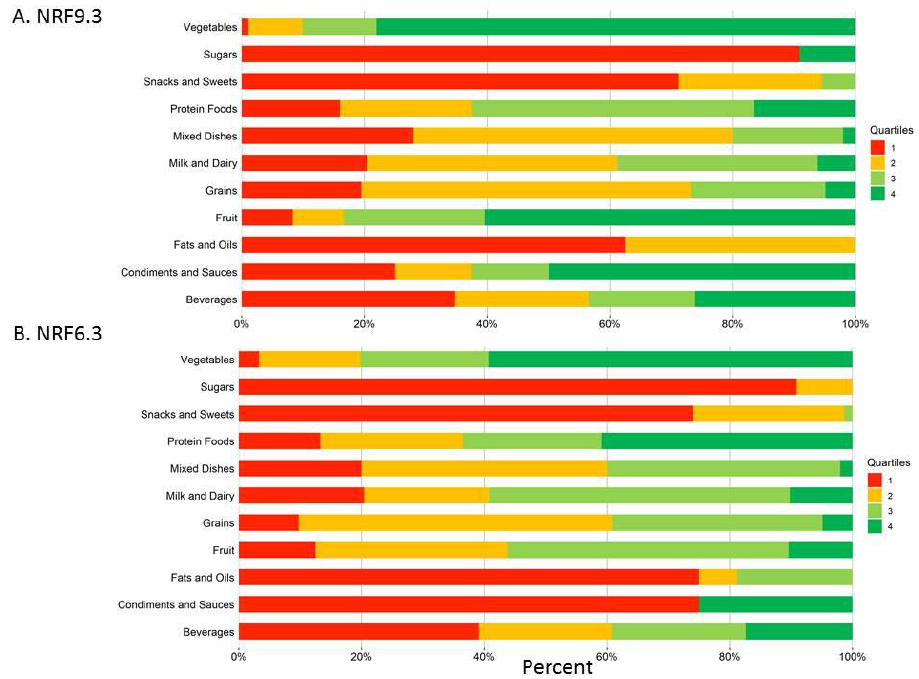
Figure 3. Percent distribution of quartiles of nutrient density scores for each food group. ( A ) Percent distribution of quartiles of nutrient density scores using NRF9.3; ( B ) Percent distribution of quartiles of nutrient density scores using NRF6.3.